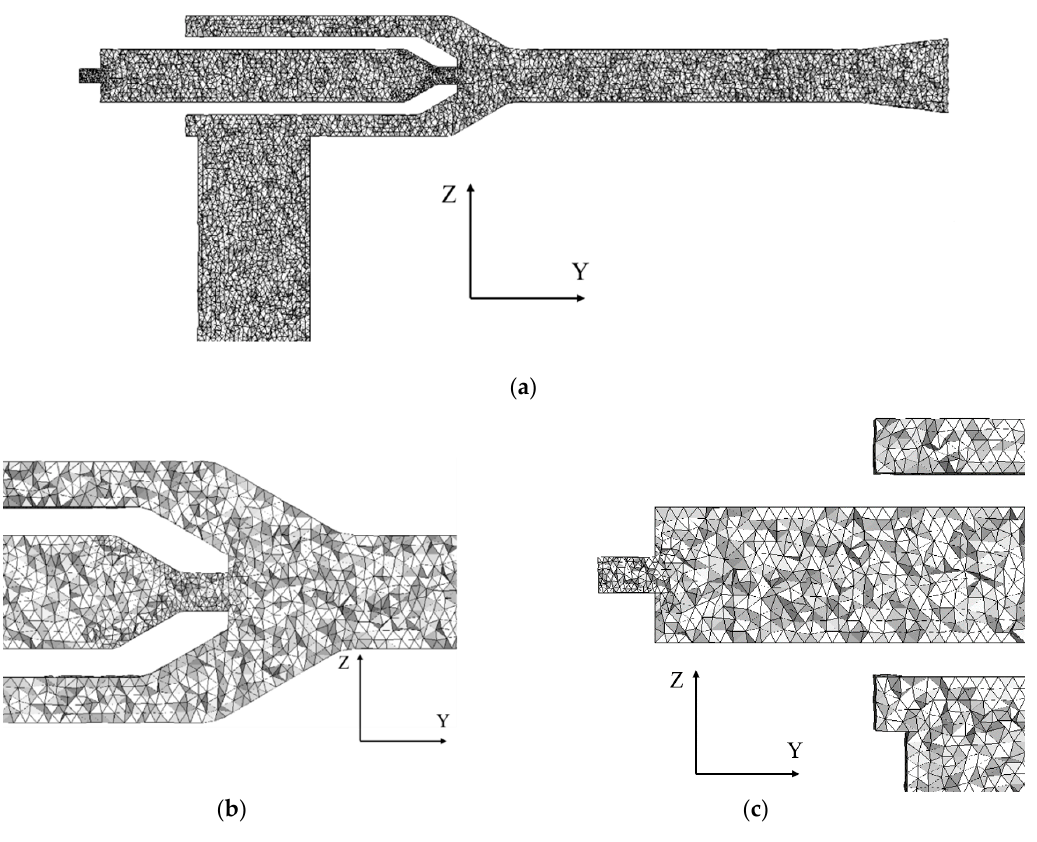
Figure 6. Mesh geometries of a pump model: ( a ) volume meshes of total domain; ( b ) volume meshes with the zoomed nozzle part; ( c ) volume meshes with the inlet part.